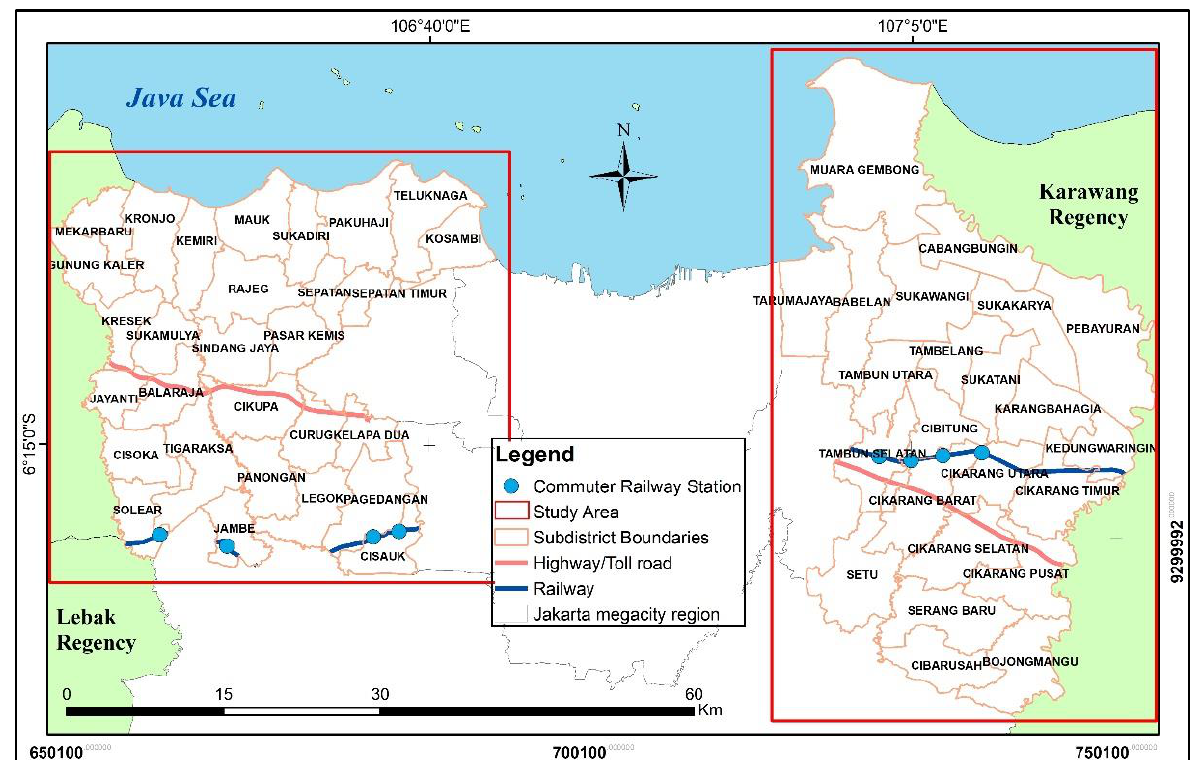
Figure 2. Study area location.